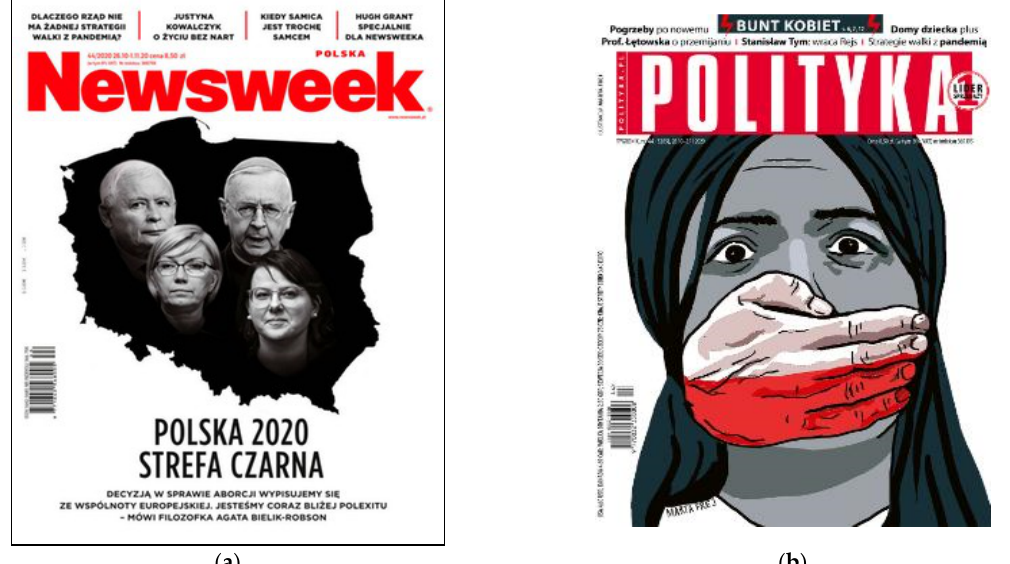
Figure 2. Selected covers interpreting Theme 1 (the anti-abortion ruling of the Constitutional Tribunal and the resultant protests). ( a ) Newsweek October 26/2020 (https://www.newsweek.pl/nwpl_202044